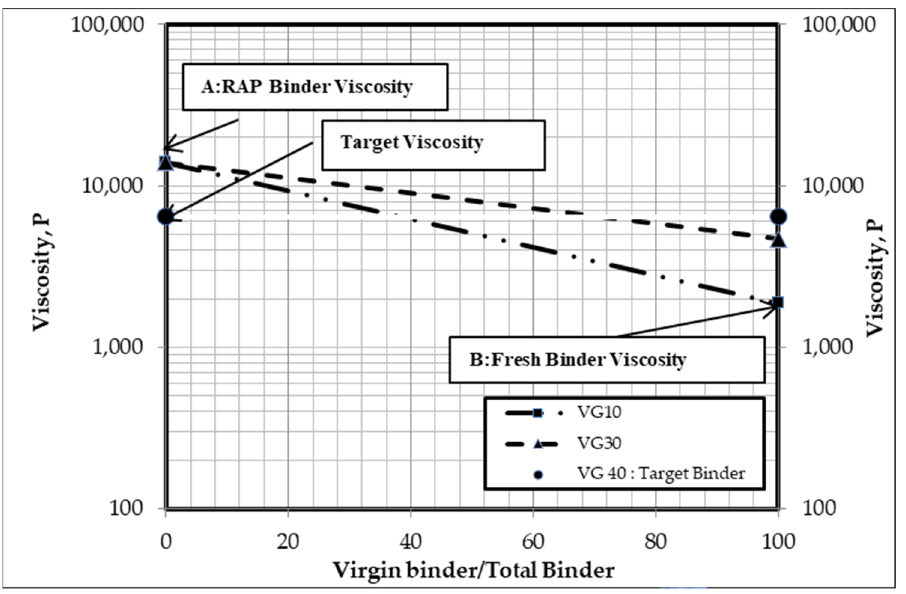
Figure 5. Viscosity Blending Chart for Kharagpur RAP. Table 11. Recycled binder % on Target Binder Viscosity for different RAP Sources. Table 10. Recycled binder % on Target Binder Viscosity for different RAP Sources.